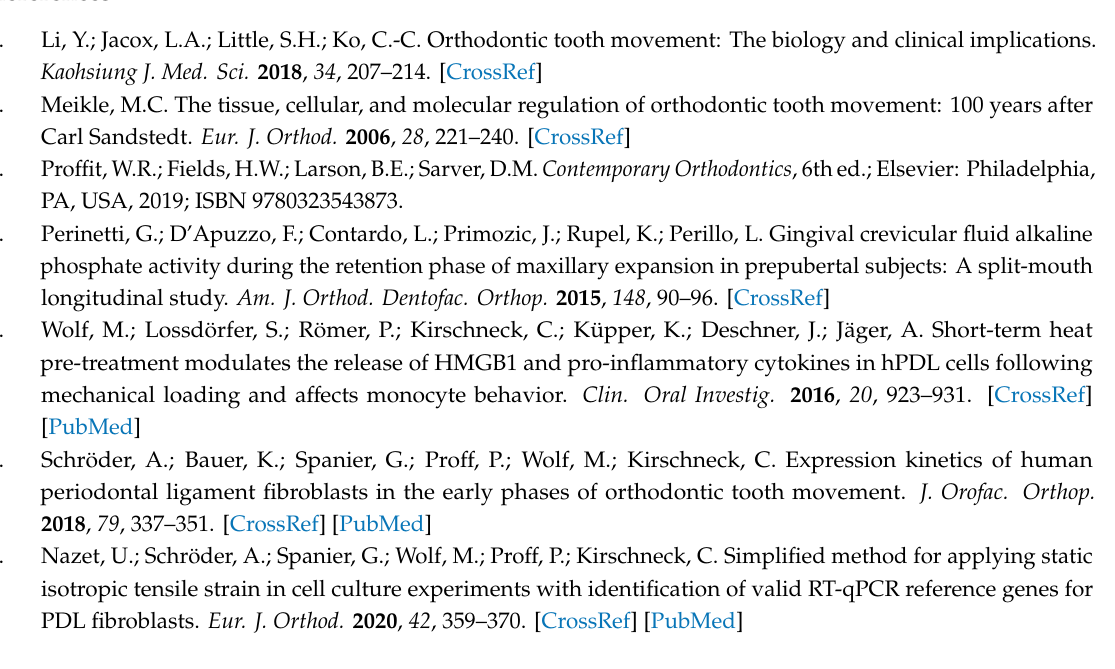
Table S1: Sequence characteristics. Table S2: Descriptive statistics for kinetics of T1-weighted MR images. Table S3: Descriptive statistics for T1-weighted morphologic images. Table S4: Descriptive statistics for area under the curve (AUC). Table S5: Descriptive statistics for peak enhancement (PE). Table S6: Descriptive statistics for time to peak (TTP). Table S7: Descriptive statistics for washout rate. Table S8: Descriptive statistics for TRAP + cells. Table S9: Descriptive statistics for CD68 + cells. Table S10: Descriptive statistics for periodontal gap. Table S11: Descriptive statistics for periodontal bone loss. Table S12: Descriptive statistics for inclination. Table S13: Descriptive statistics for distance between the first and second